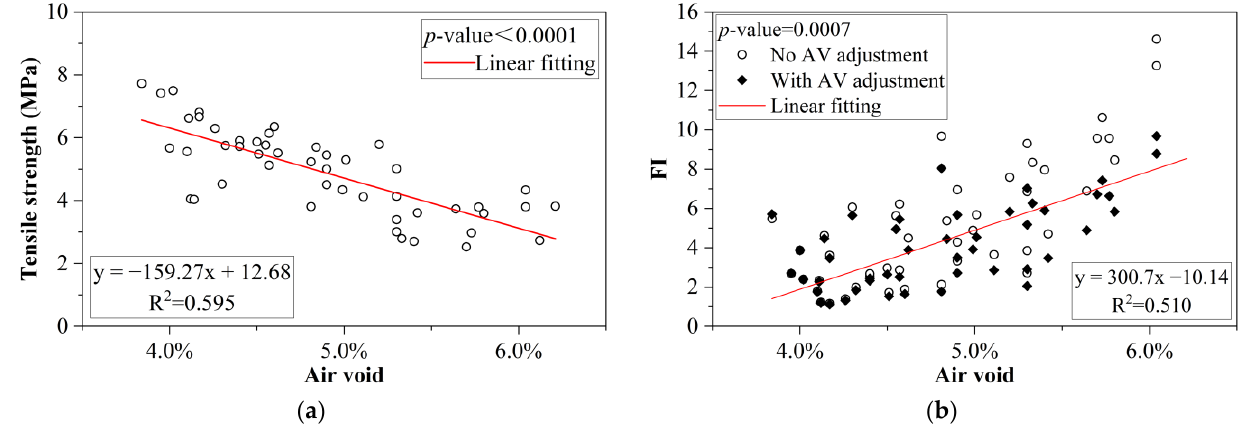
Figure 13. Relationship between significant factors and air void for the bottom layer: ( a ) tensile strength versus air void and ( b ) FI versus air void. Table 4. Summary of factors affecting the cracking resistance for three asphalt layers.